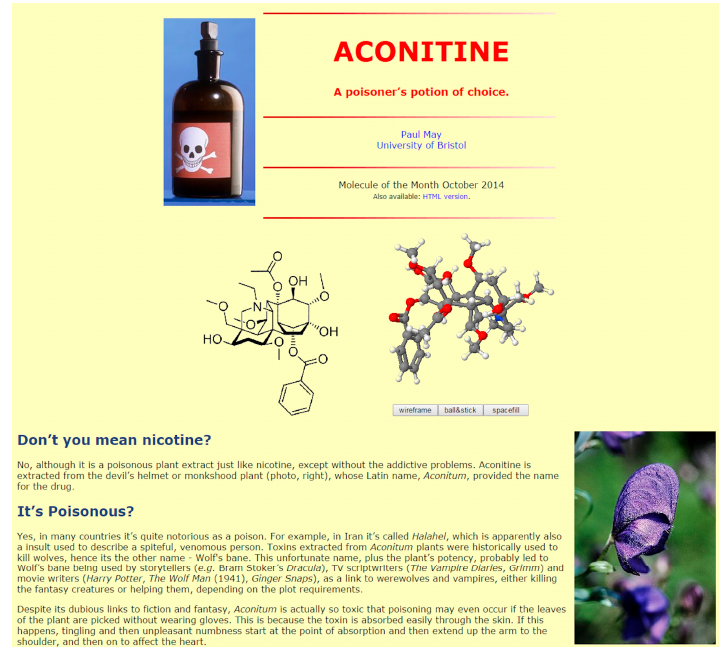
Figure 2. The MOTM page for October 2014 was about the poison aconitine [18]. The JSMol version includes both the 2D structure (on the left) and the interactive 3D structure (on the right).